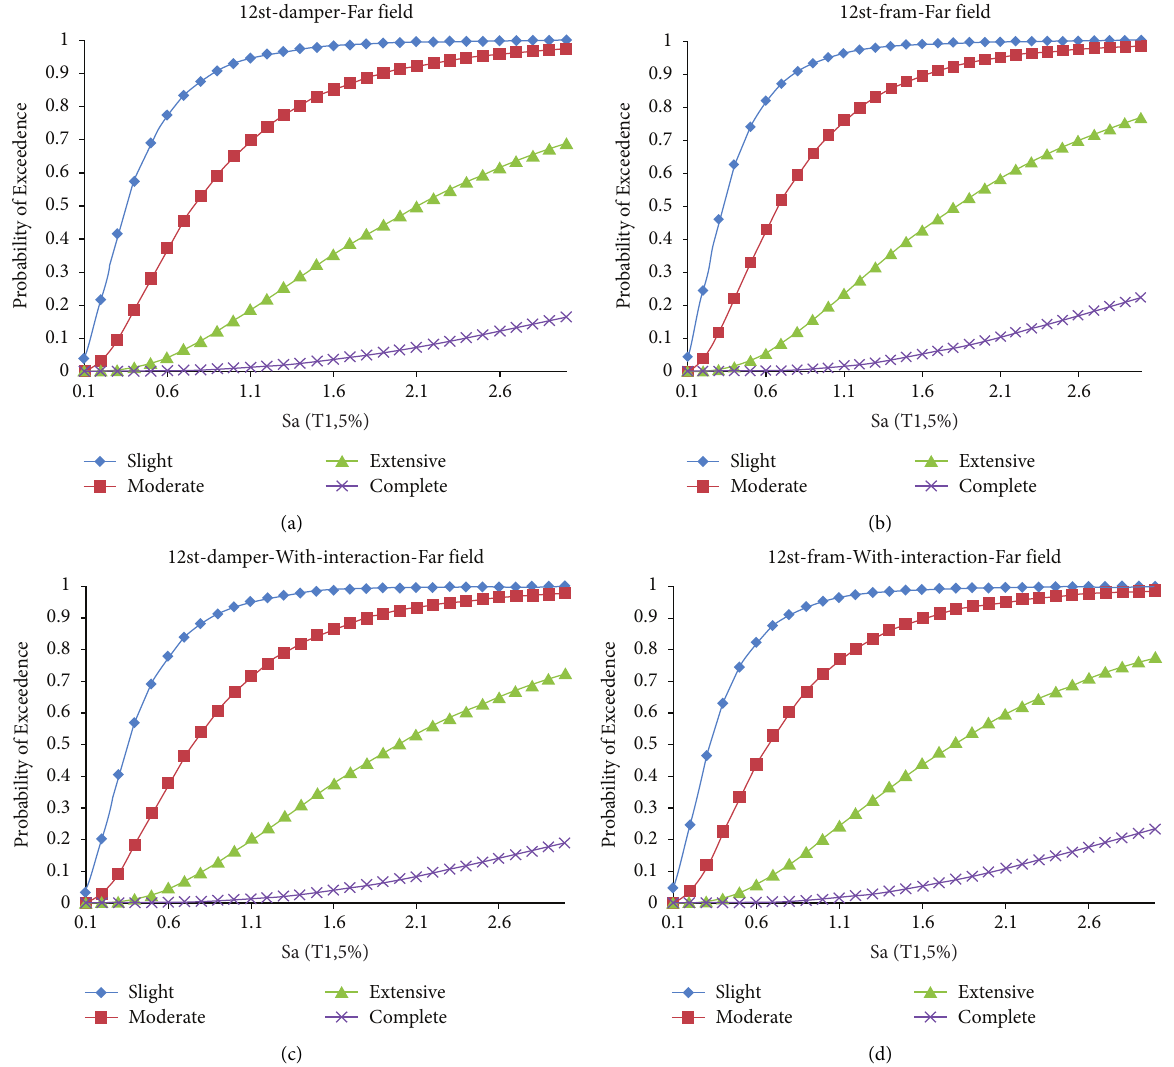
Figure 16: Fragility curves in 12-story ordinary moment resisting frame affected by far-field earthquakes. Examined cases: (a) with damper without considering SSI; (b) without damper and SSI effect; (c) with damper and considering SSI; (d) without damper but considering SSI